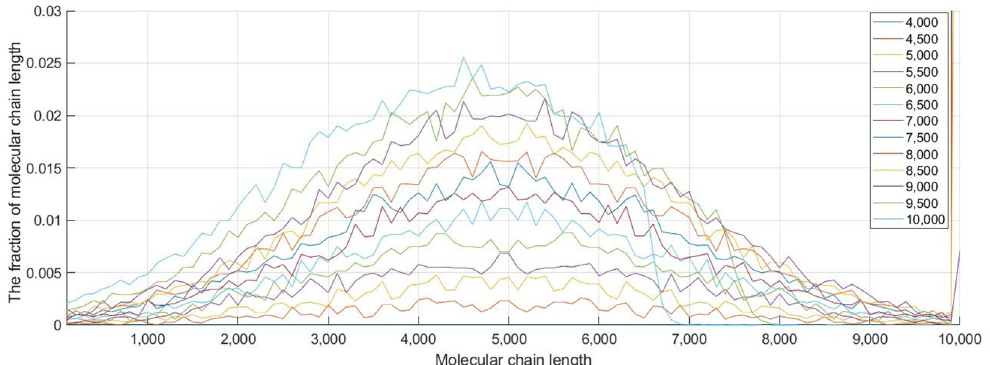
Figure 6. The distribution of PMVS molecular chain length under different L u